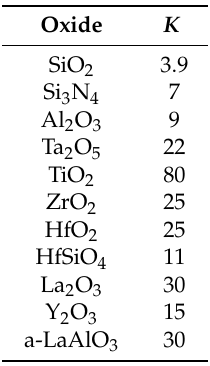
Table 1. Static dielectric constant of a few gate